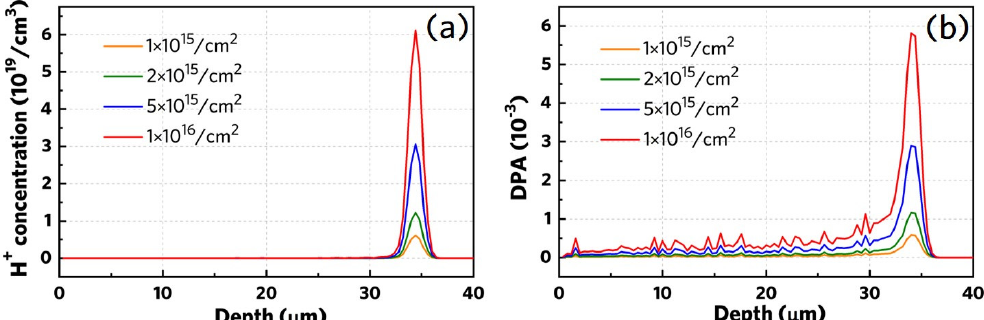
Figure 2. ( a ) PBW − induced H + concentration and ( b ) defects per atom as a function of the 2 MeV proton beam penetration depth in Nd:YCOB crystal at fluences of 1 × 10 15 , 2 × 10 15 , 5 × 10 15 , and 1 × 10 16 cm − 2 calculated by SRIM 2013 code.